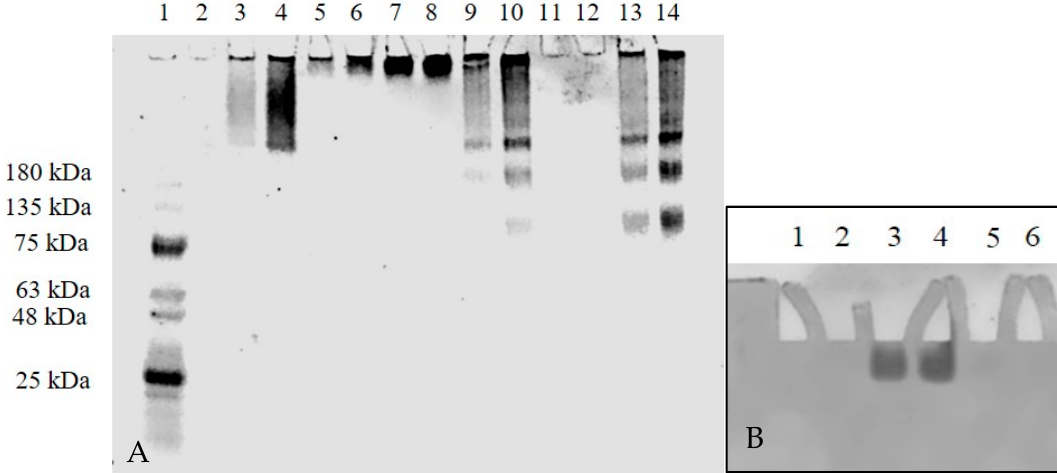
Figure 4. mAb migration on 4–20% Tris-Glycine PAGE gel under non-reducing conditions followed by Coomassie Blue R-250 stain. The image was taken using a Coomassie Blue filter. ( A ) Lane 1: molecular marker; Lane 2: purified human IgG 10 µg; Lane 3: bovine gamma globulin 5 µg; Lane 4: bovine gamma globulin 10 µg; Lane 5: T-DM1 5 µg; Lane 6: T-DM1 10 µg; Lane 7: BV 5 µg; Lane 8: